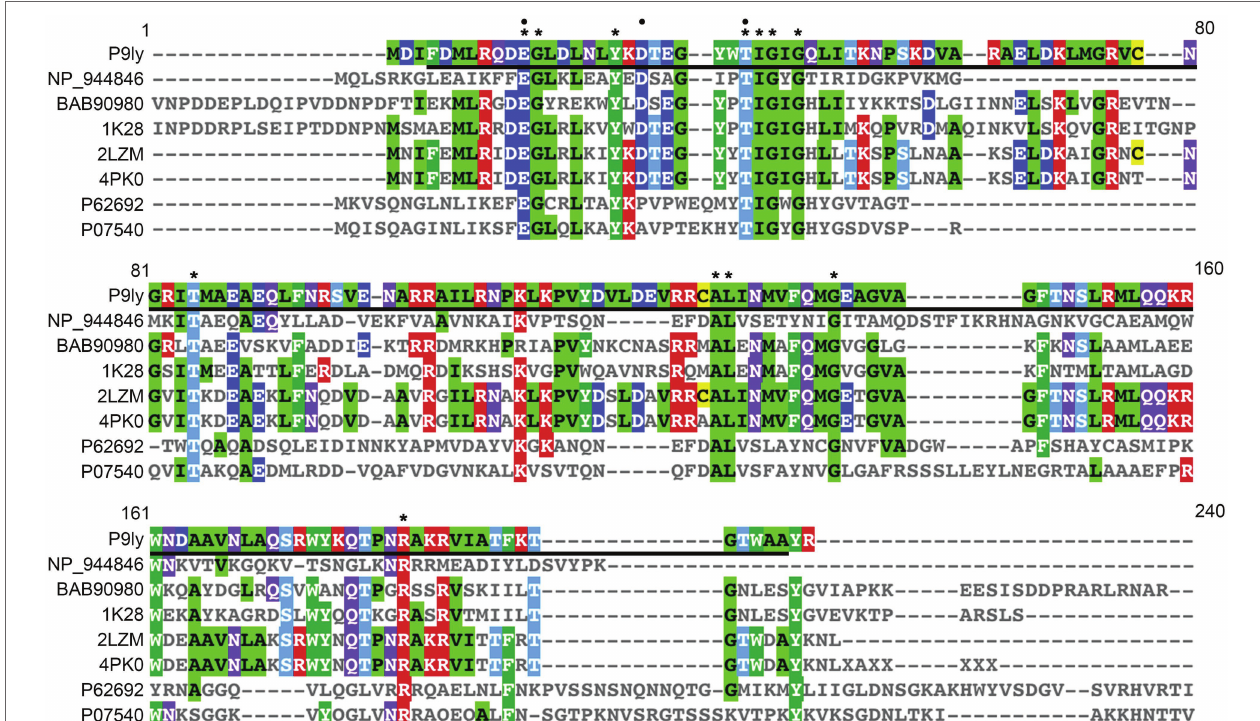
FIGURE 2 | Multiple sequence alignment of lytic enzyme P9ly and other seven representative members of the lyz-like family. This analysis was performed using the EBI tool CLUSTAL Omega 1.2.4. In the figure, a star denotes conserved amino acid residues among all the sequences, while a black circle indicates critical residues that built the enzyme’s catalytic center. Bold underlined regions show the position of the T4-like_lys domain in the lytic enzyme P9ly. The accession numbers of NP_944846, BAB90980, 1K28, 2LZM, 4PK0, P62692, and P07540 represent protein sequences of the lysozyme from Salmonella phage FelixO1 (GenBank ID: 38707815), tail lysozyme from Escherichia phage RB49 (GenBank ID: 20218971), chain A, tail-associated lysozyme from Escherichia virus T4 (GenBank ID: 18655470), chain A, T4 lysozyme from Escherichia virus T4 (GenBank ID: 157835331), chain A, lysozyme from Actinoplanes teichomyceticus (GenBank ID: 683437436), endolysin from Lactococcus virus c2 (GenBank ID: 50402201), and endolysin from Bacillus phage PZA (GenBank ID: 126604), respectively.